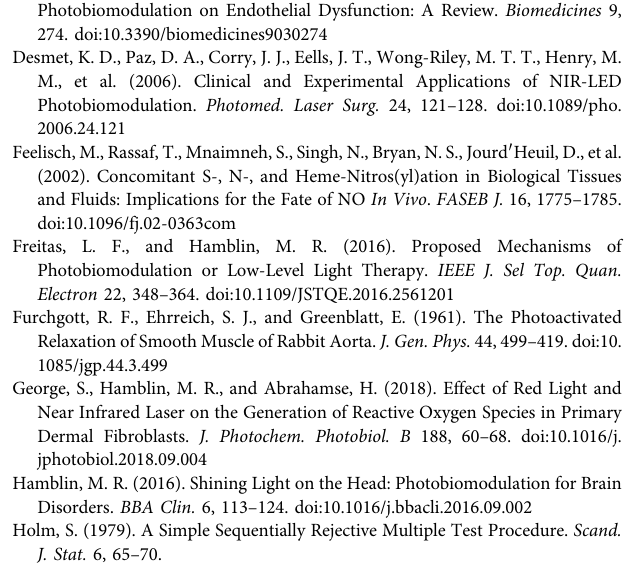
Supplementary Figure S2 | Representative image of the LDI measurement using ameroid constrictor. The animals received the optimal duration and intensity of 670 nm light for 14 days. Doppler perfusion of the plantar foot was assessed within anatomically de fi ned regions of interest, consisting of the hind paw margins, immediately before and after light